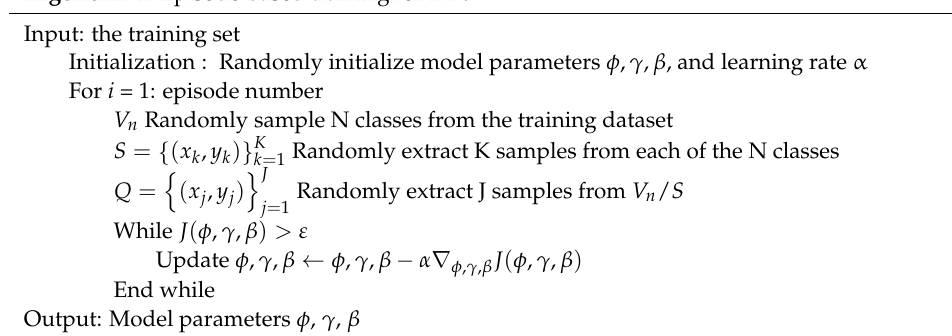
Algorithm 1 : Episode-based training for IPN